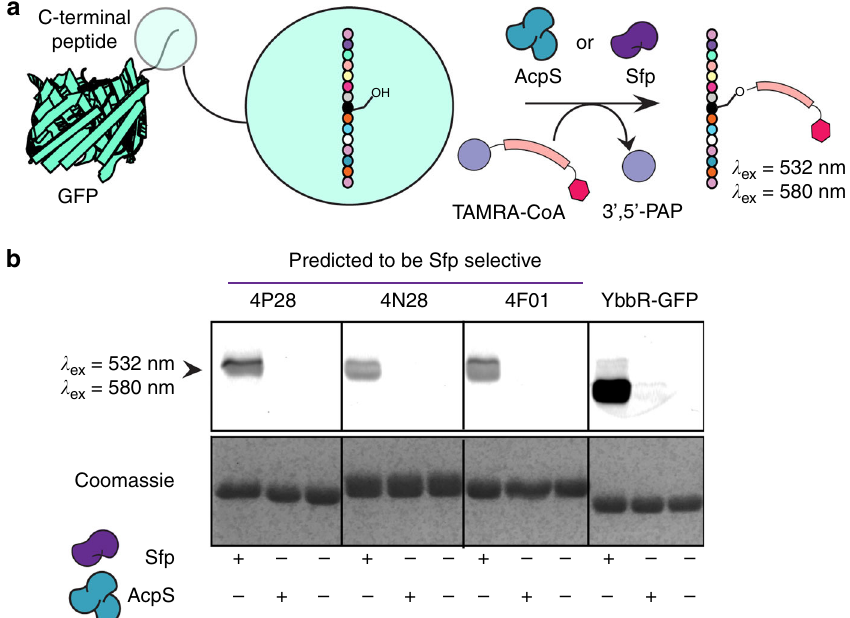
Fig. 5 Validation of PPTase-speci fi c peptide hits using GFP-peptide tags. a Modi fi cation of GFP-peptide fusions by addition of TAMRA-CoA onto selective peptides appended on the C - terminus of GFP. b Twelve percent SDS-PAGE gel corresponding to labeling ( λ ex = 532 nm/ λ em = 580 nm) of GFP peptide tag by Sfp and AcpS. PPTase (Sfp and AcpS) is not observed due to low abundance (Coomassie sensitivity). TAMRA-CoA was present in each enzymatic